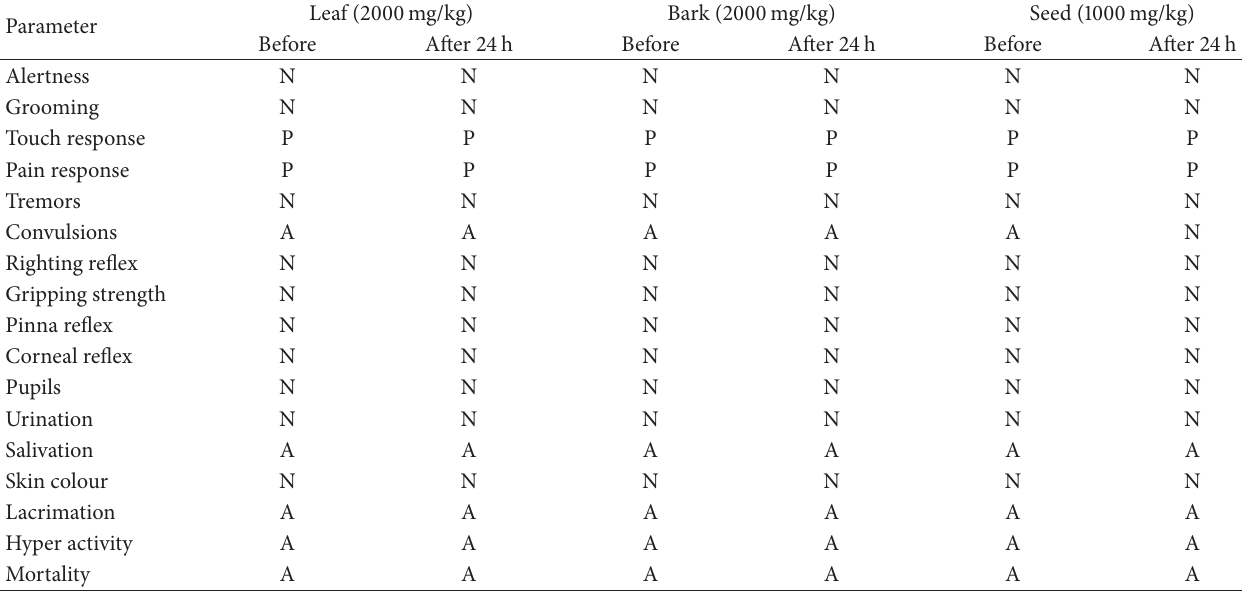
Table 1: Behavioral changes during the main study for acute oral toxicity analyses of C . australe ethanol extracts. Leaf (2000 mg/kg) Bark (2000 mg/kg) Seed (1000mg/kg) Parameter Before After 24 h Before After 24 h Before After 24 h Alertness N N